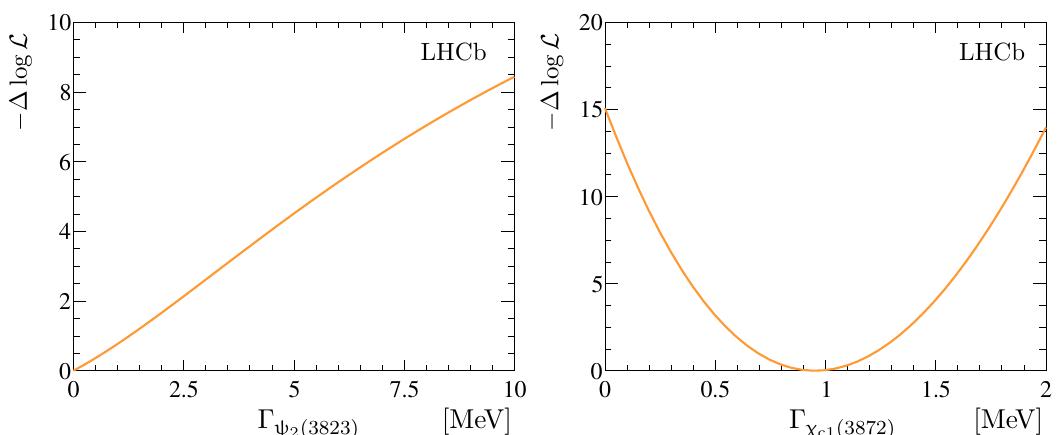
Figure 3 . Likelihood pro(cid:12)les for the Breit-Wigner width of (left) 2 (3823) and (right) (cid:31) c1 (3872)